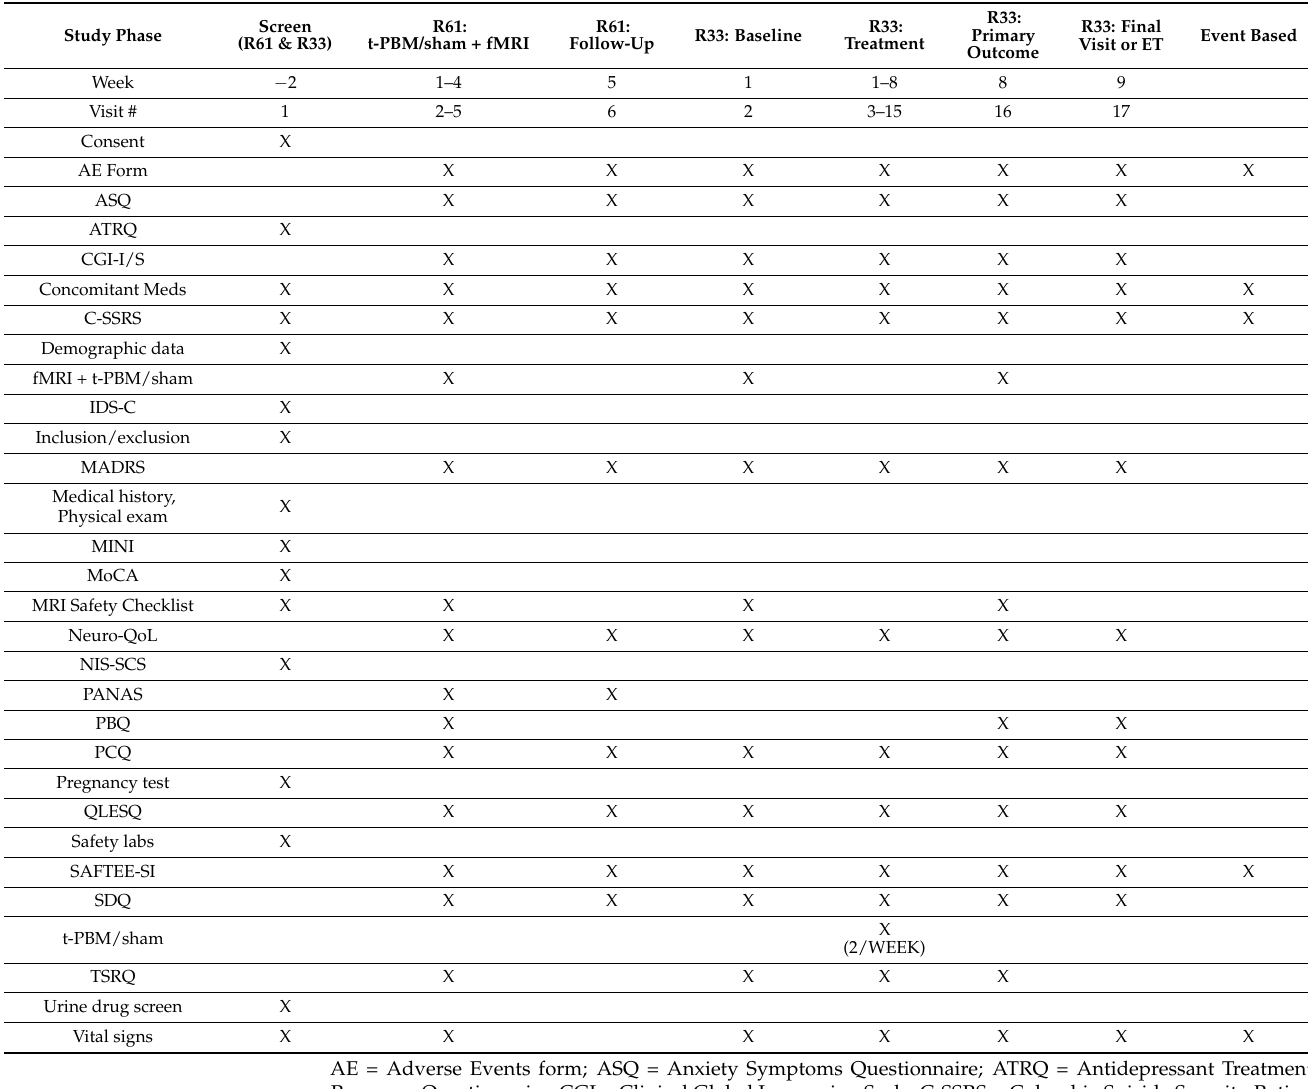
Table 1. The schedule of events and procedures at each study